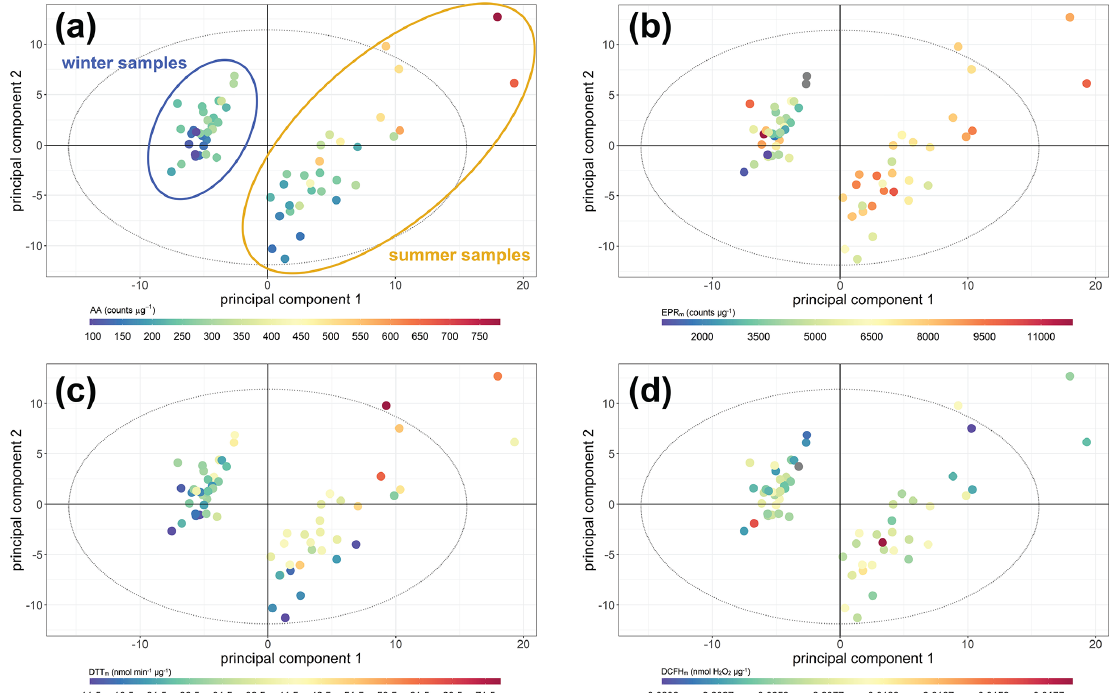
Figure 6. Principal component analysis score plot of all data. (a) Coloured by AA m response; (b) coloured by EPR m response; (c) coloured by DTT m response; (d) coloured by DCFH m response. Both principal component 1 and principal component 2 demonstrate variance associated with AA and DTT response, and there is greater variation associated with the winter response than the summer response (highlighted in panel a ). PC 1 R 2 X 35.90%, Q 2 29.28%; PC 2 R 2 X 19.34%, Q 2 23.73%; the model included six principal components, with a cumulative R 2 X of 68.2% and Q 2 of